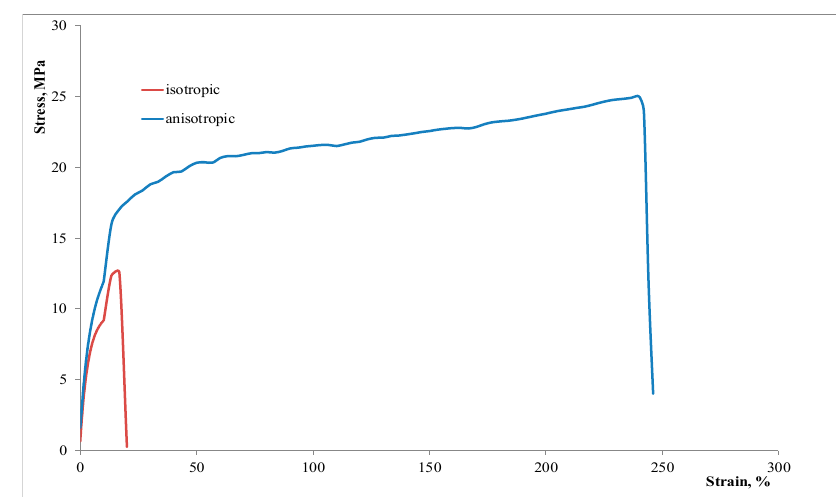
Figure 7. Stress–strain curves of binary blend samples (isotropic vs. anisotropic).